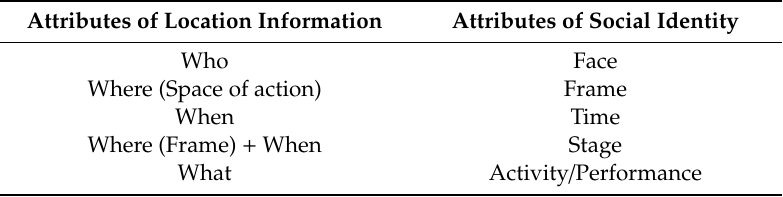
Table 7. Attributes of Location Information and Attributes of Social